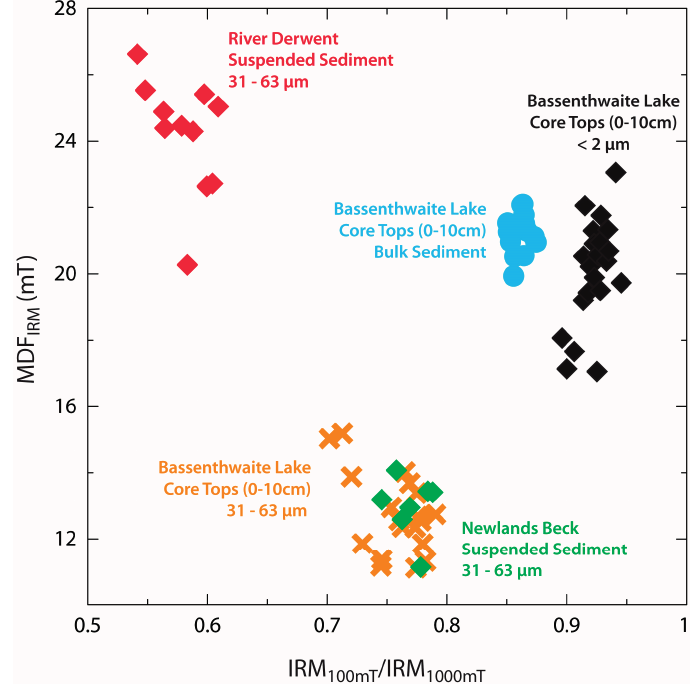
Figure 6. Magnetic fingerprints for Bassenthwaite Lake core top sediments and catchment sources. Note how the bulk lake sediments (blue circles) have similar magnetic properties to the clay fraction (black diamonds) while the coarse silt fraction (orange crosses) differs significantly from these two falling on a mixing line between Newlands Beck (green diamonds) and River Derwent (red diamonds) suspended sediments. Isolation of the coarse silt fraction permits comparison with catchment inflows while the bulk magnetic properties are strongly influenced by bacterial magnetosomes that reside in the clay fraction. All data from Hatfield and Maher